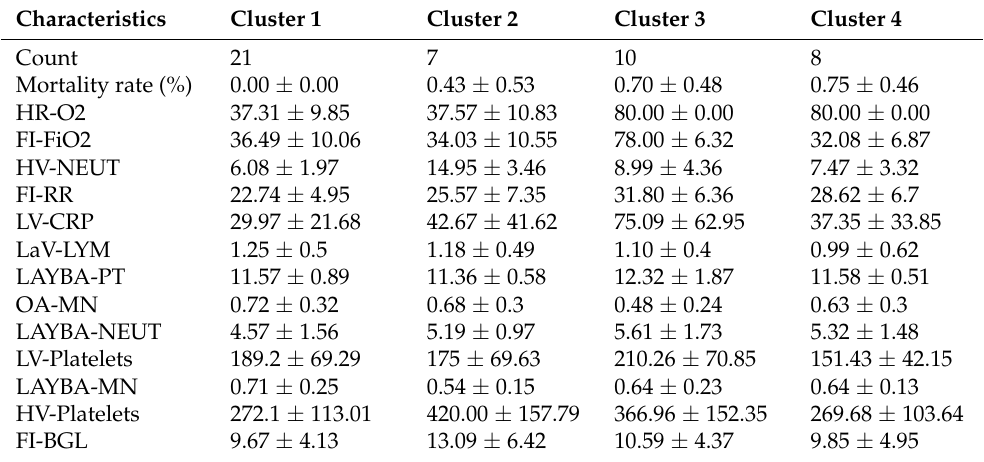
Table 3. The results of the performed SHAP clustering to generate a mortality risk stratification